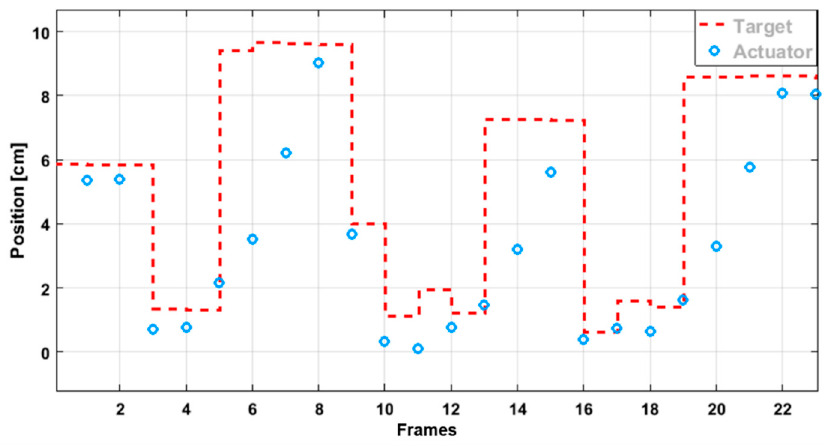
Figure 10. Actuator tracking a moving target object.